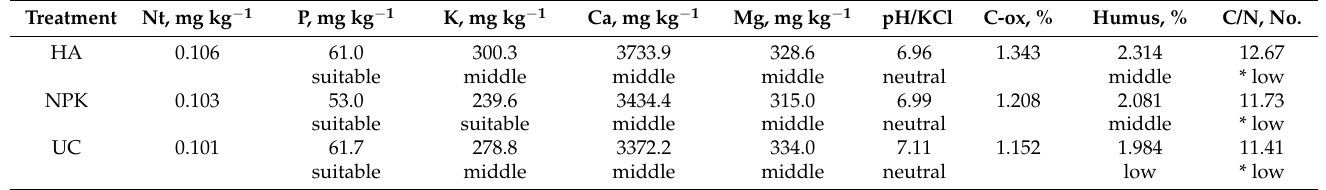
Table 2. The average content of nutrients in the soil (0–30 cm) and the initial status of 2017 (autumn).